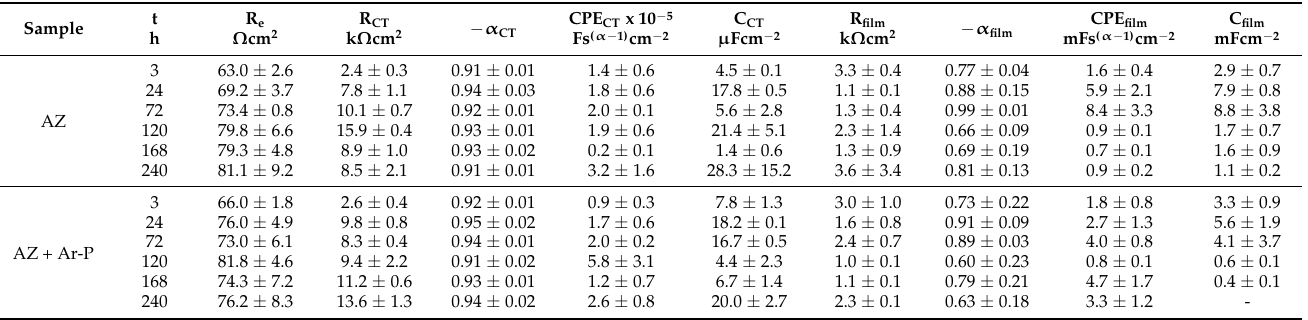
Table 4. Impedance fit parameters obtained AZ31 alloy in 0.1 M Na 2 SO 4 solution.